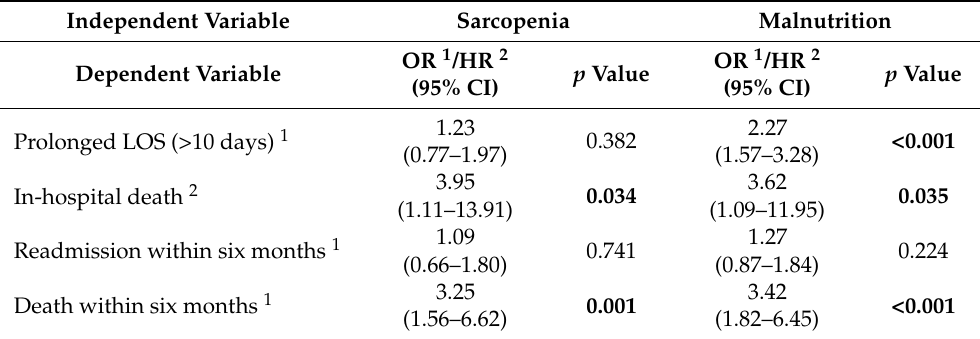
Table 2. Association between probable sarcopenia or sarcopenia and clinical outcomes: multivari- ate